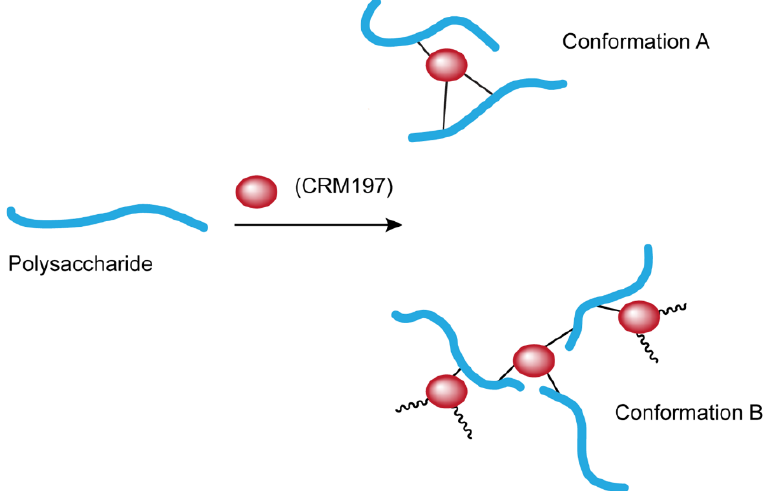
Figure 1. A PCV monovalent conjugate (MVC) and its conformations. ST-1 polysaccharide has a free primary amine and two carboxylic acid groups among